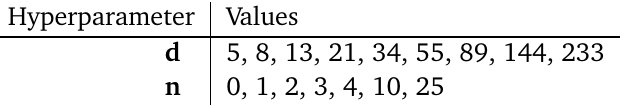
Table 1: Parameter combinations used for training the Deep SVDD models. The hyperparameter d represents the output dimensionality, i.e. the number of output parameters of the network, while n stands for the target output